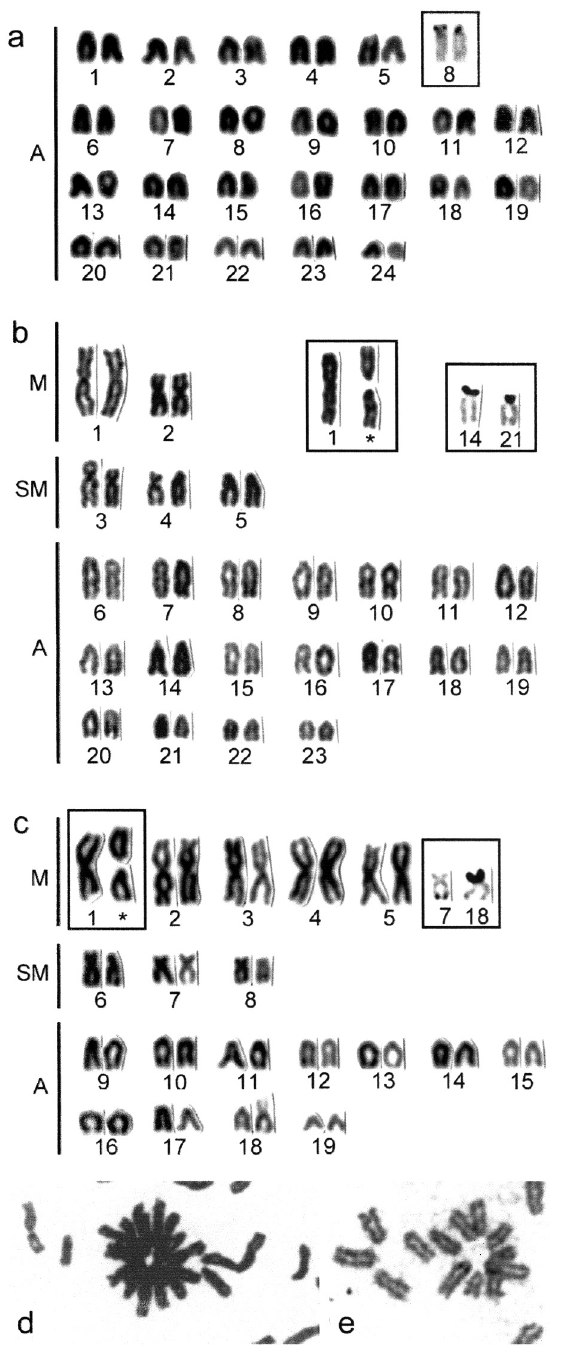
Figure 1 - Giemsa stained karyotypes of Chromis multilineata (a), C. insolata (b) and C. flavicauda (c) with chromosomes related to centric fu- sionindicatedinthelargerboxes.TheAg-NORbearingchromosomesare in the smaller boxes. Partial metaphases showing the radial configuration of acrocentric chromosomes in C. flavicauda (d) and C. insolata